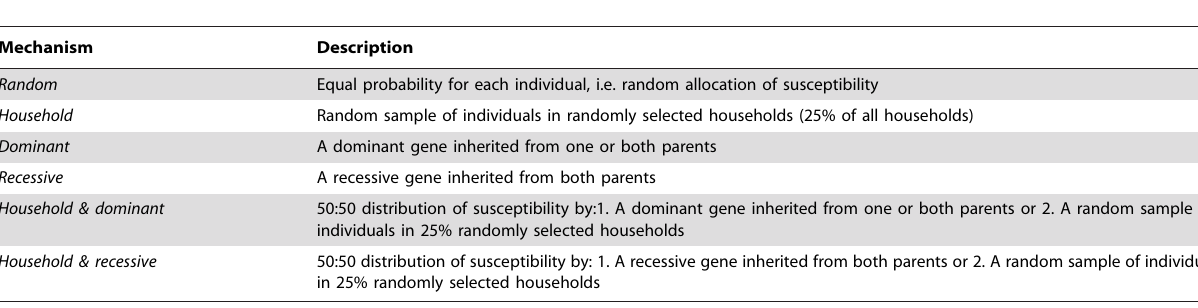
Table 1. Description of the six mechanisms determining the heterogeneity in